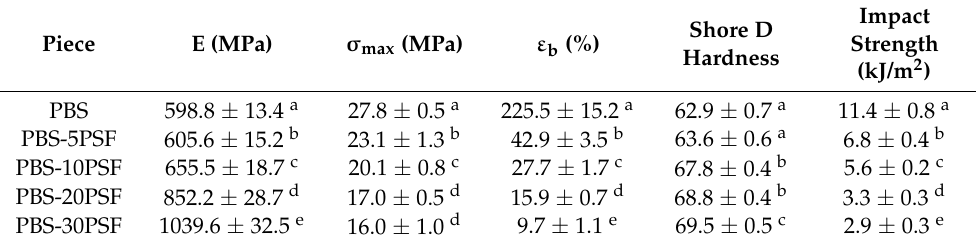
Table 2. Mechanical properties of the injection-molded pieces of poly(butylene succinate) (PBS)/pistachio shell flour (PSF) compatibilized with poly(butylene succinate) grafted with maleic an- hydride (PBS-g-MAH) in terms of tensile modulus (E), maximum tensile strength ( σ max ), elongation at break ( ε b ), Shore D hardness, and impact